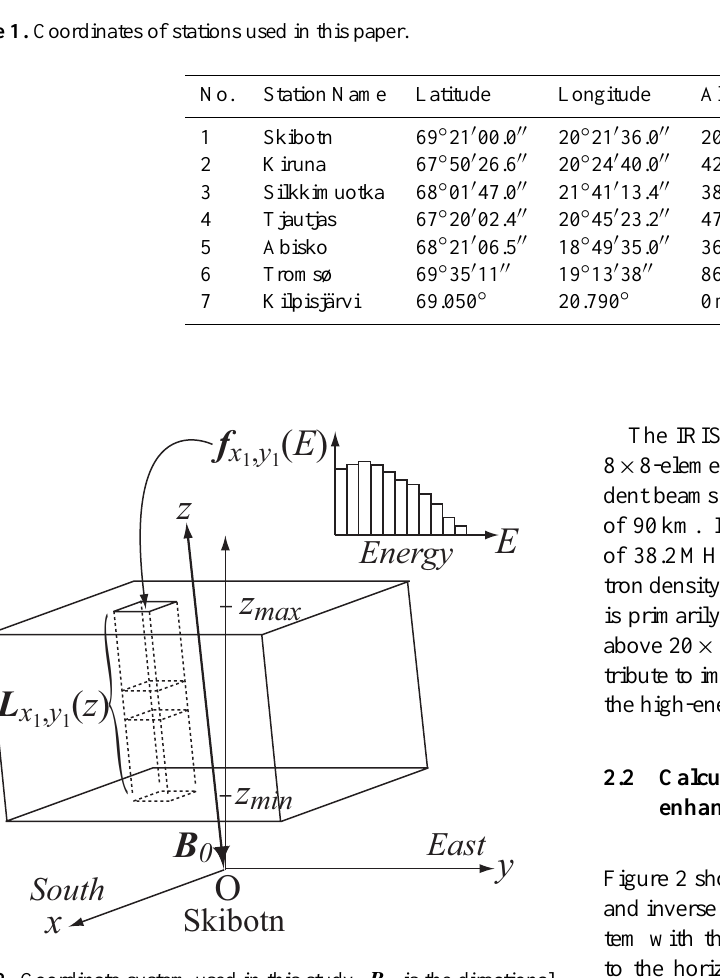
Fig. 2. Coordinate system used in this study. B 0 is the directional vector of the geomagnetic